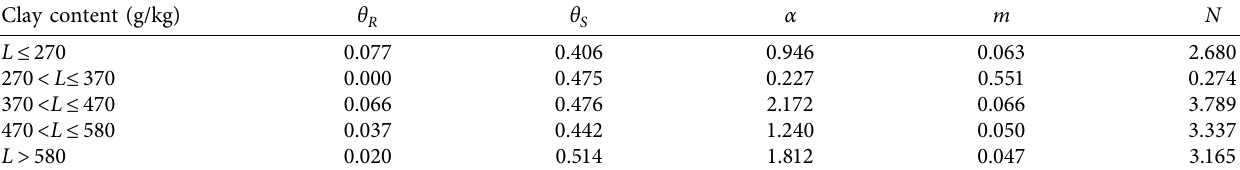
Table 2: Parameter estimates for water retention curves of Cambisols adapted from Oliveira et al. [27].